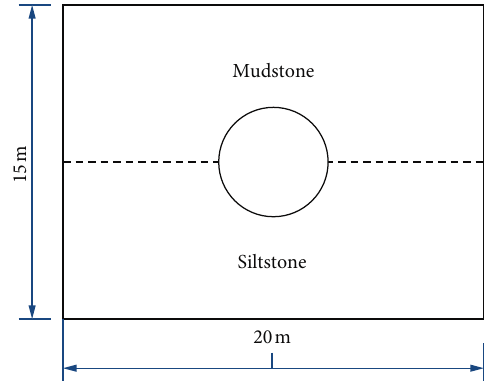
Figure 1: TBM tunnel mixed stratigraphic section.